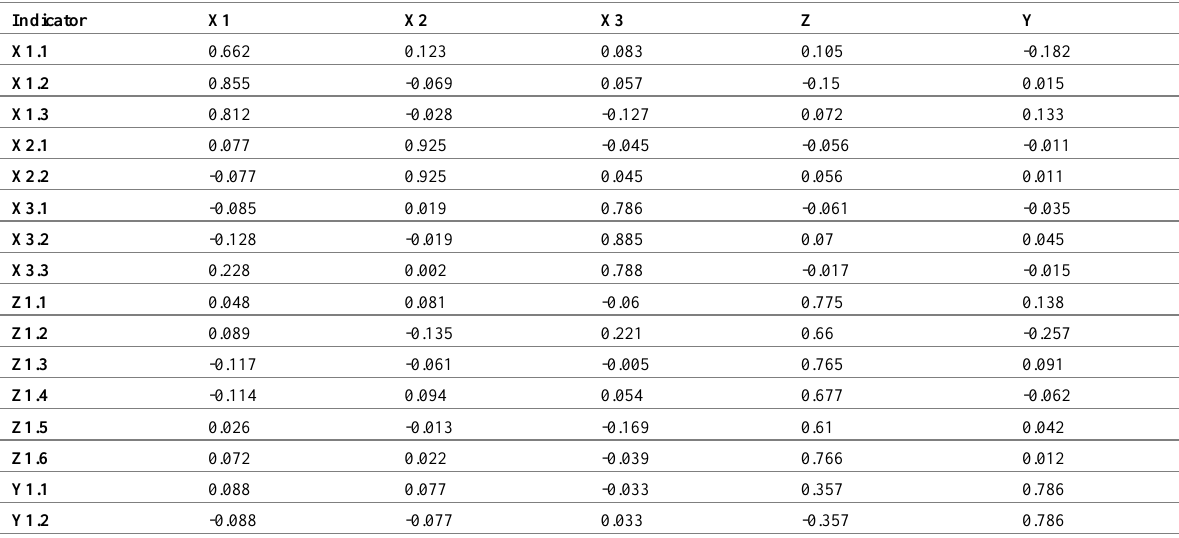
Table 2: Discriminant